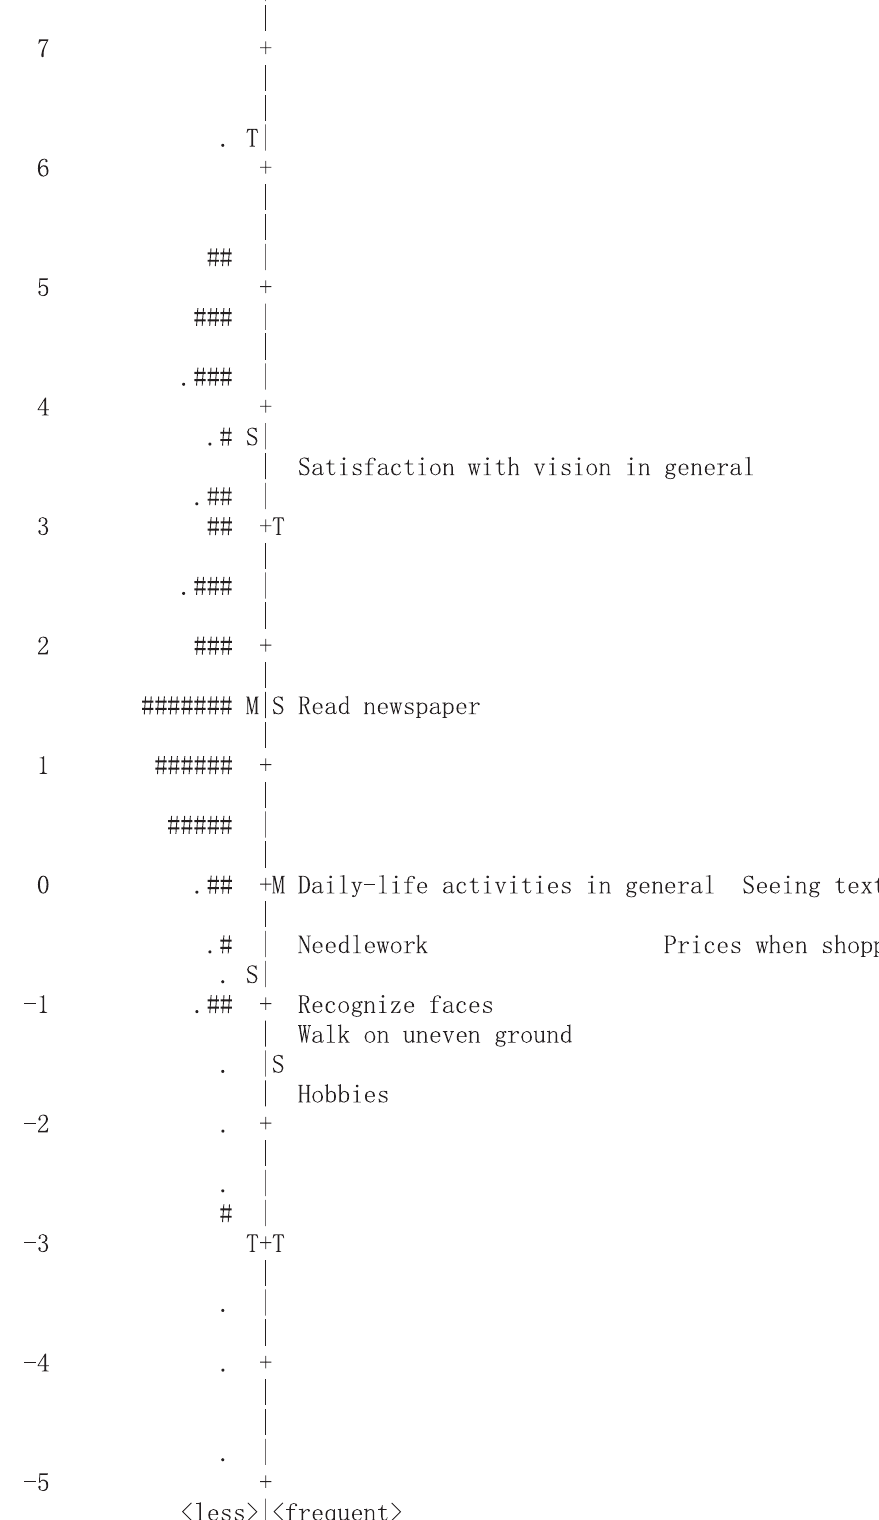
Figure 2. Person-item map of the Chinese version of the Catquest-9SF. doi:10.1371/journal.pone.0103860.g002 PLOS ONE |